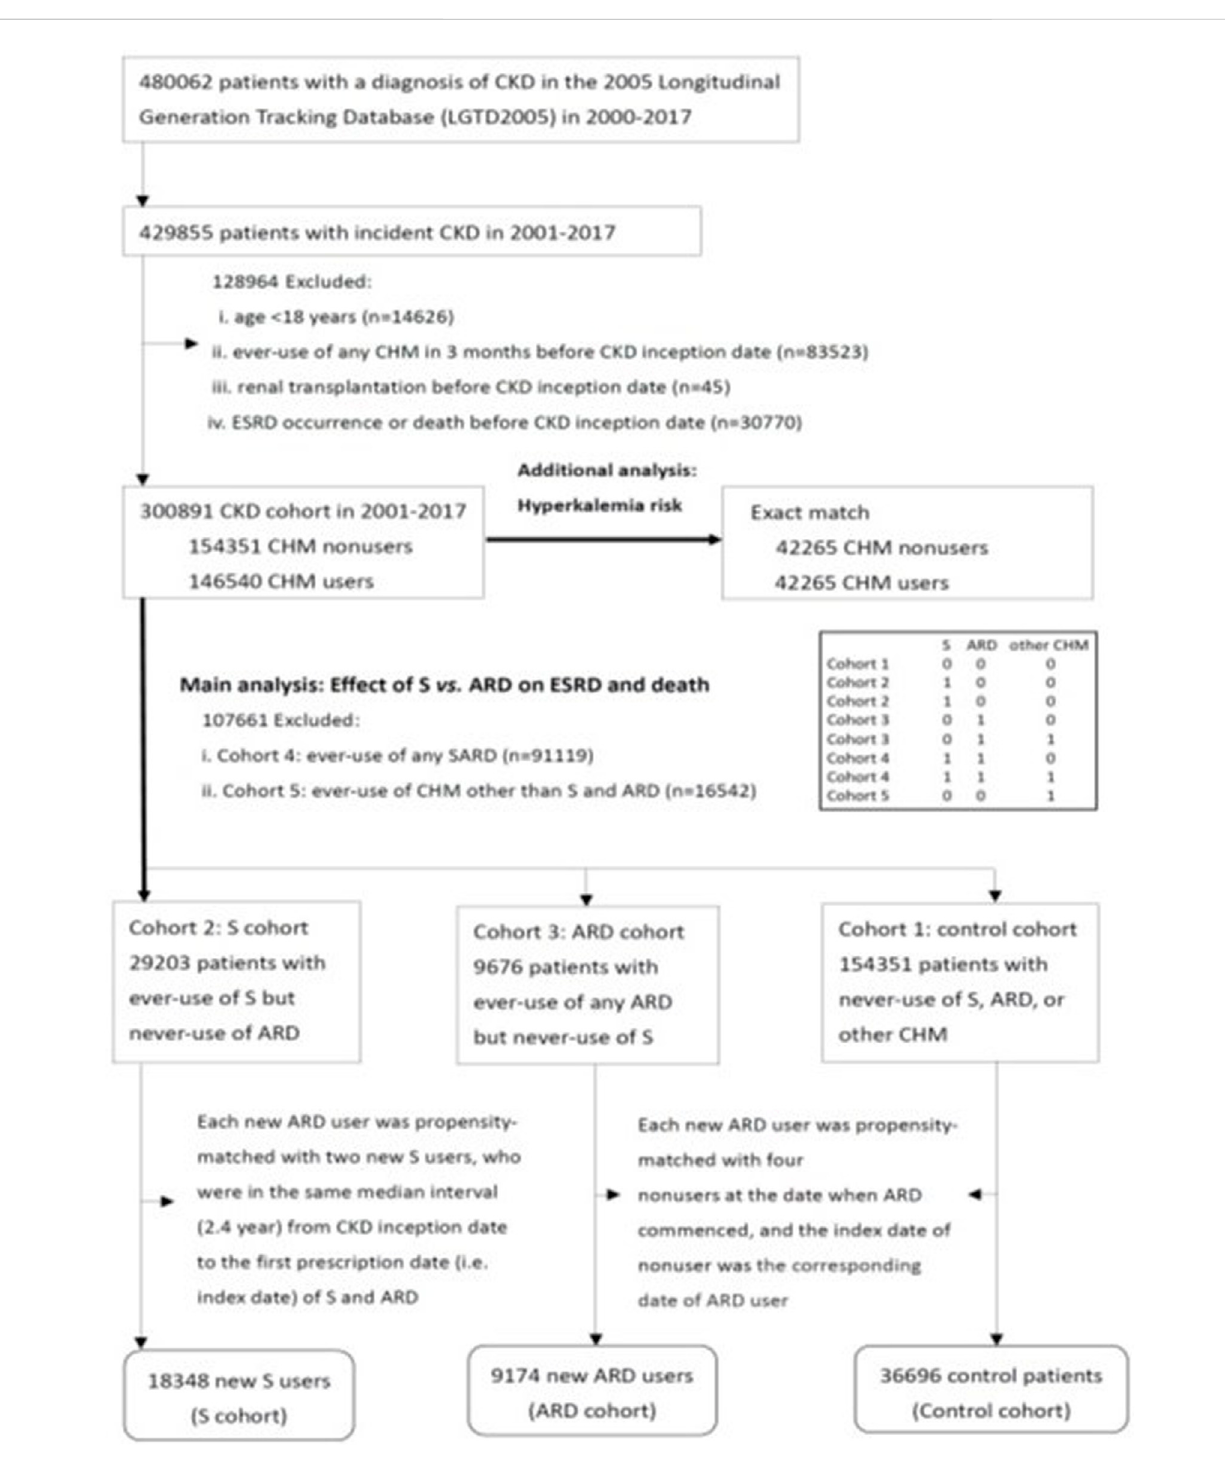
FIGURE 1 Flow diagram of three study cohorts. Abbreviations: CKD, chronic kidney disease; ESRD, end-stage renal disease; CHM, Chinese herbal medicine; ARD, A: Astragalus membranaceus (Fisch.) Bunge, R: Rheum palmatum L., and D: Danshen ( Salvia miltiorrhiza Bunge); S, Angelica sinensis (Oliv.) Diels